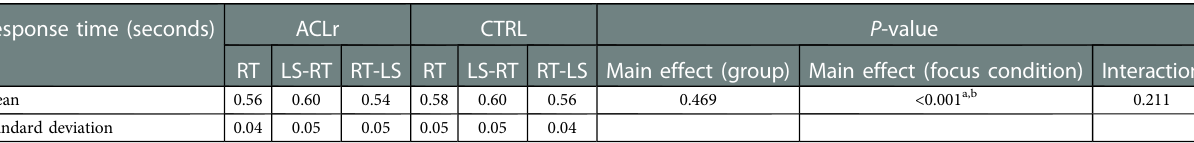
TABLE 3 The effects of group and prioritization on response time, and pairwise comparisons across three focus conditions. Response time (seconds)